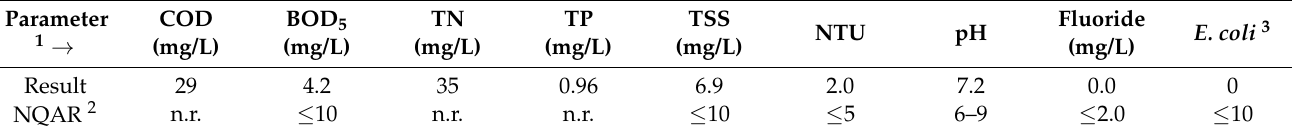
Table 2. Quality parameters of the reclaimed water after tertiary treatment by the pilot-scale constructed wetland.